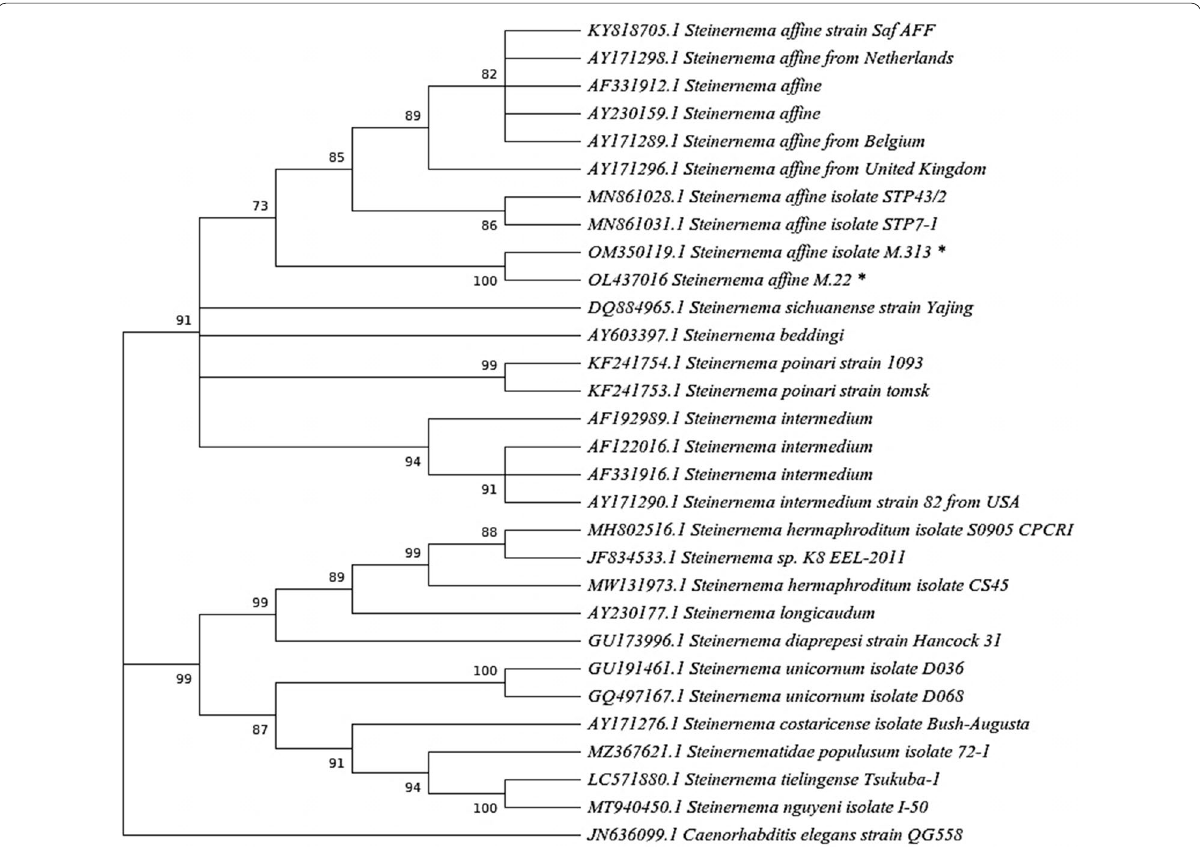
Fig. 5 Maximum likelihood phylogenetic tree of Steinernema nematodes based on ITS sequences. The evolutionary relationships were computed using the Hasegawa–Kishino–Yano model. The tree with the highest log likelihood ( 8485.52) is shown. Numbers at nodes represent bootstrap − values higher than 70% based on 100 replications. A discrete gamma distribution was used to model evolutionary rate differences among sites (5 categories ( G, parameter 2.1835)). The tree is drawn to scale, with branch lengths measured in the number of substitutions per site. This analysis + = involved 30 nucleotide sequences. Codon positions included were 1st 2nd 3rd Noncoding. There were a total of 1184 positions in the final + + + dataset. Evolutionary analyses were conducted in MEGA X. The obtained isolates in this study are marked with star